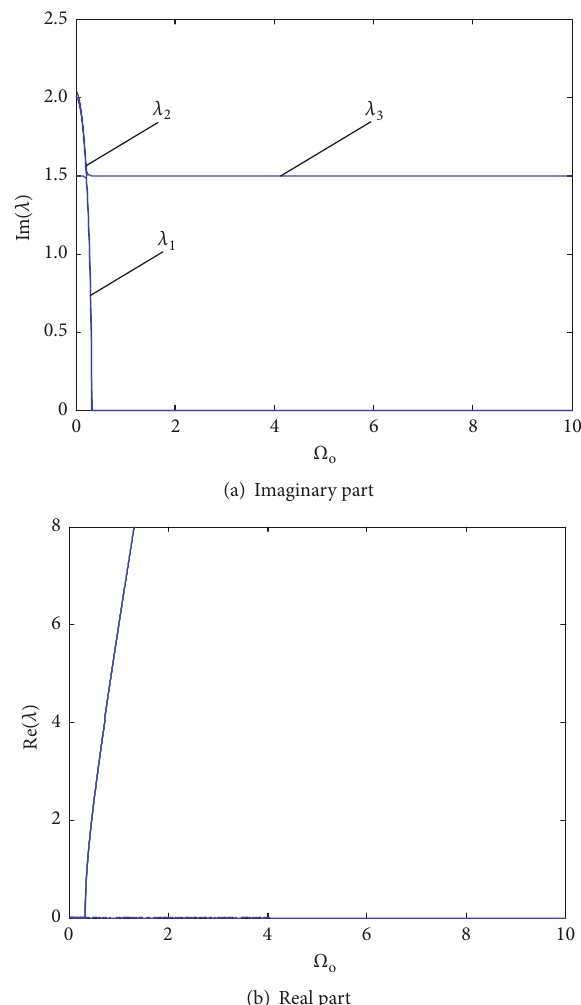
Figure 7: Imaginary and real parts of the eigenvalue for planetary component